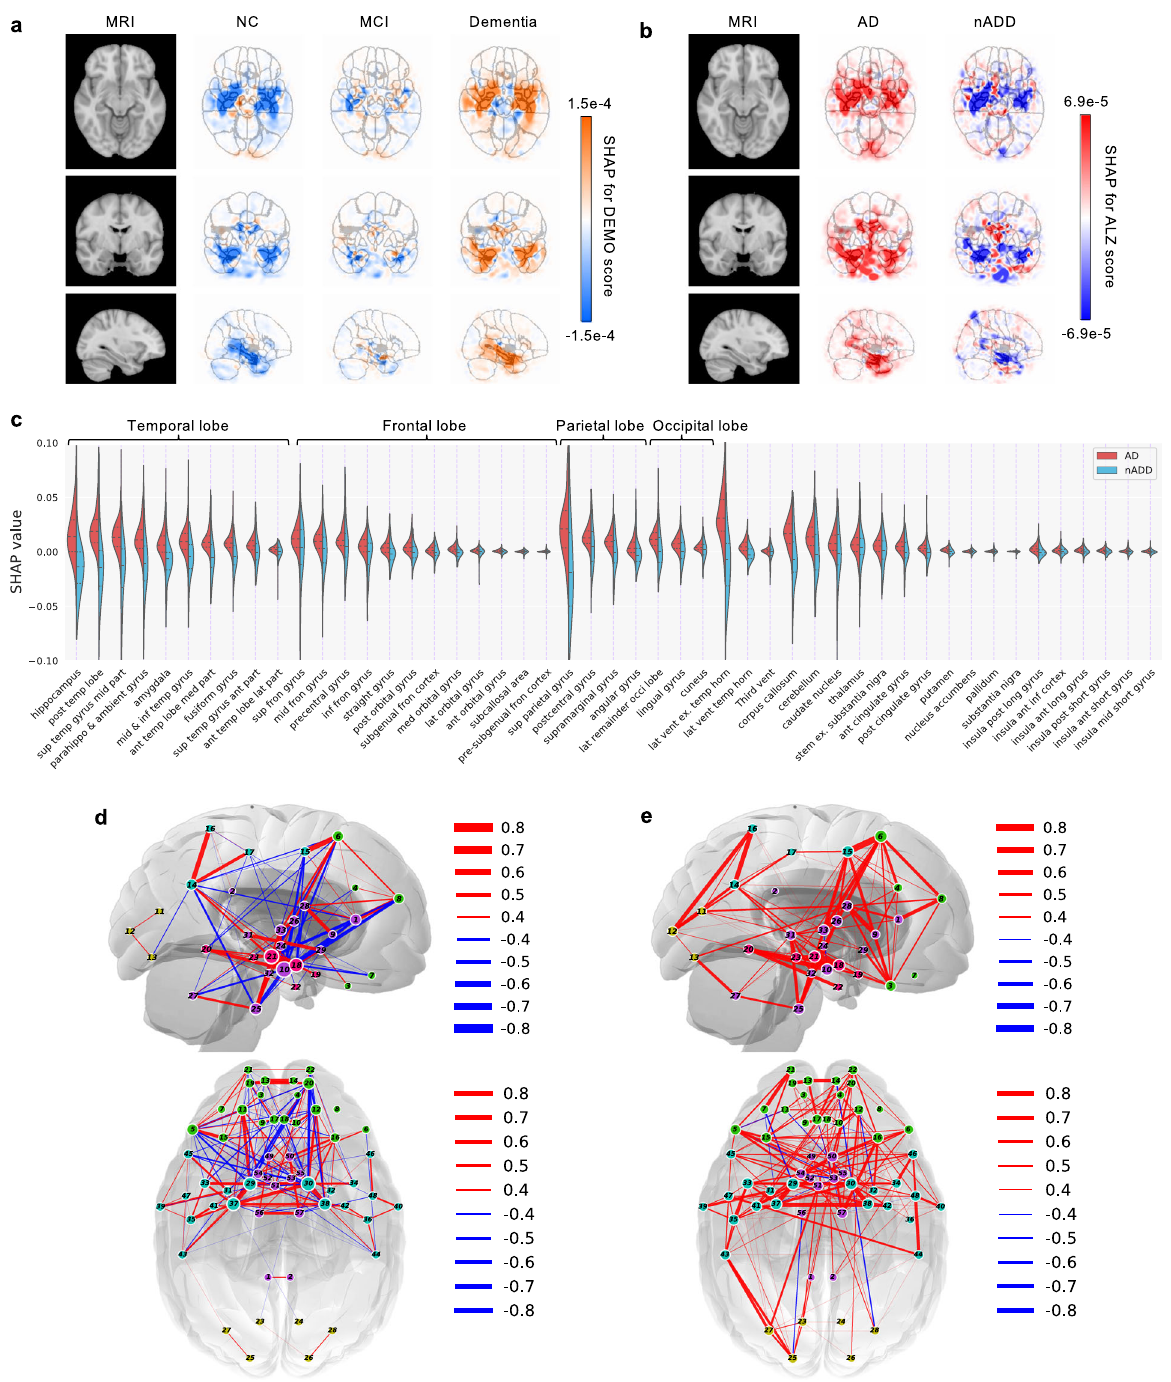
Fig. 4 Neuroimaging signatures of dementia. a , b SHAP value-based illustration of brain regions that are most associated with the outcomes. The fi rst columns in both a and b show a template MRI oriented in axial, coronal, and sagittal planes. In a , the second, third and fourth columns show SHAP values from the input features of the second convolutional block of the CNN averaged across all NACC test subjects with NC, MCI, and dementia, respectively. In b , the second and third columns show SHAP values averaged across all NACC test subjects with AD and nADD, respectively. c Brain region-speci fi c SHAP values for both AD and nADD cases obtained from the NACC testing data are shown. The violin plots are organized per lobe and in decreasing order of mean absolute SHAP values. d , e Network of brain regions implicated in the classi fi cation of AD and nADD, respectively. We selected 33 representative brain regions for graph analysis and visualization of sagittal regions, as well as 57 regions for axial analyses. Nodes representing brain regions are overlaid on a two-dimensional brain template and sized according to weighted degree. The color of the segments connecting different nodes indicates the sign of correlation and the thickness of the segments indicates the magnitude of the correlation. It must be noted that not all nodes can be seen either from the sagittal or the axial planes. Source data are provided as a Source Data fi